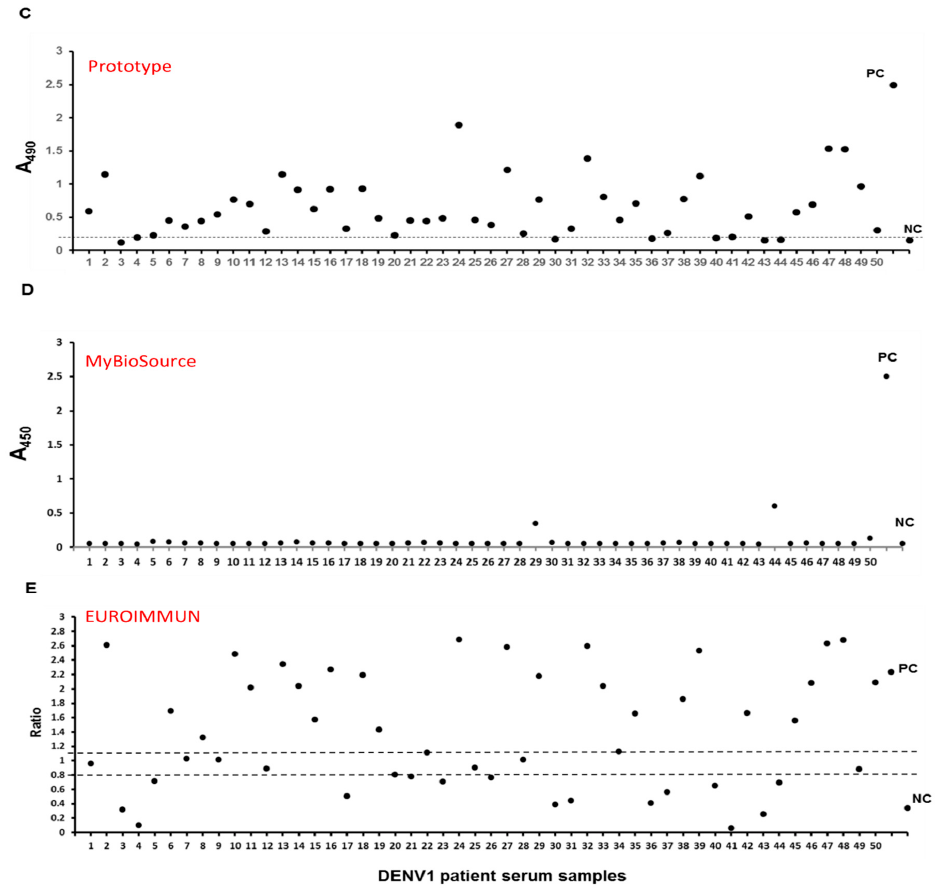
Figure 4. Detection of NS1 in sera from patients infected with DENV1. ( A ) Detection of NS1 in sera of patients infected with DENV1 using the ELISA-based diagnostic platform. NC represents RT-PCR negative control serum; NHS represents normal human serum. The dashed line represents the cut off value; ( B ) Detection of NS1 in the sera of patients infected with DENV1 using the flow cytometry-based diagnostic platform. NC represents RT-PCR negative control serum; NHS represents normal human serum; ( C ) Fifty serum samples were collected and analyzed by the ELISA-based diagnostic platform. Diluted normal human serum (1 to 100 in Thermo IgG elution buffer) with the purified DENV1 NS1 protein (1 μ g) as the positive control (PC); diluted normal human serum (1 to 100 in Thermo IgG elution buffer) without the purified DENV1 NS1 protein as the negative control (NC). The dashed line represents the cut off value which was set at the average value of 50 NHS plus triple standard deviation; ( D ) Fifty serum samples were analyzes by the commercial kit (MyBioSource), PC, positive control; NC, negative control; ( E ) Fifty serum samples were analyzed by the commercial kit (EUROIMMUN). The y-axis is the ratio of each sample or controls (Ratio = extinction of the control or patient sample/extinction of calibrator 2). Ratio ≥ 1.1: positive; Ratio ≥ 0.8 to < 1.1: borderline; Ratio < 0.8: negative. PC, positive control; NC, negative control. Above data were repeated by two to three independent experiments.